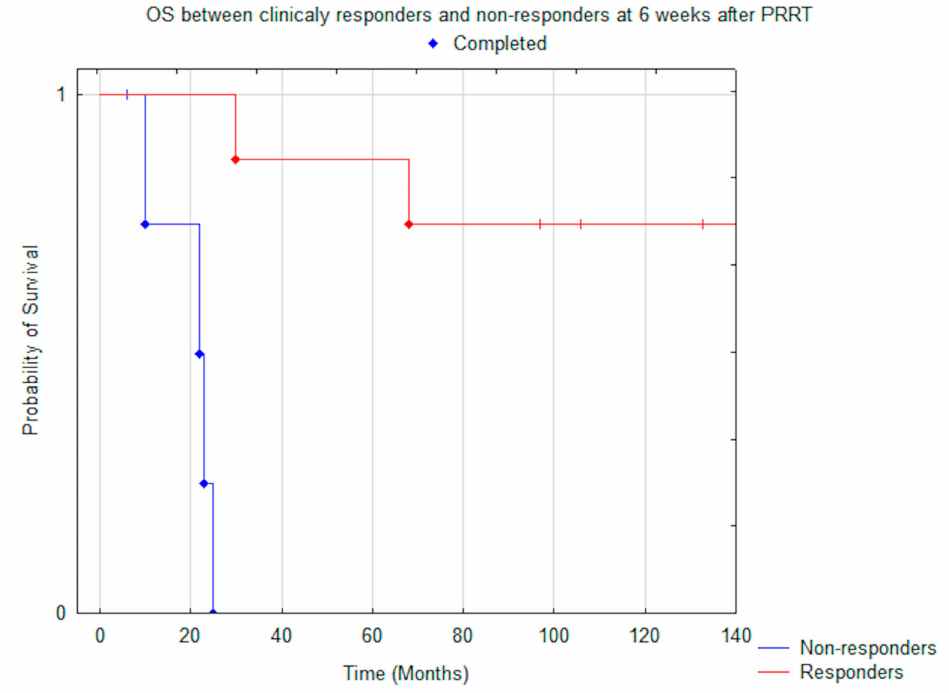
Figure 4. Comparison of median OS between clinically responders ( n = 8) and non-responders ( n = 5) at six weeks after PRRT ( p =